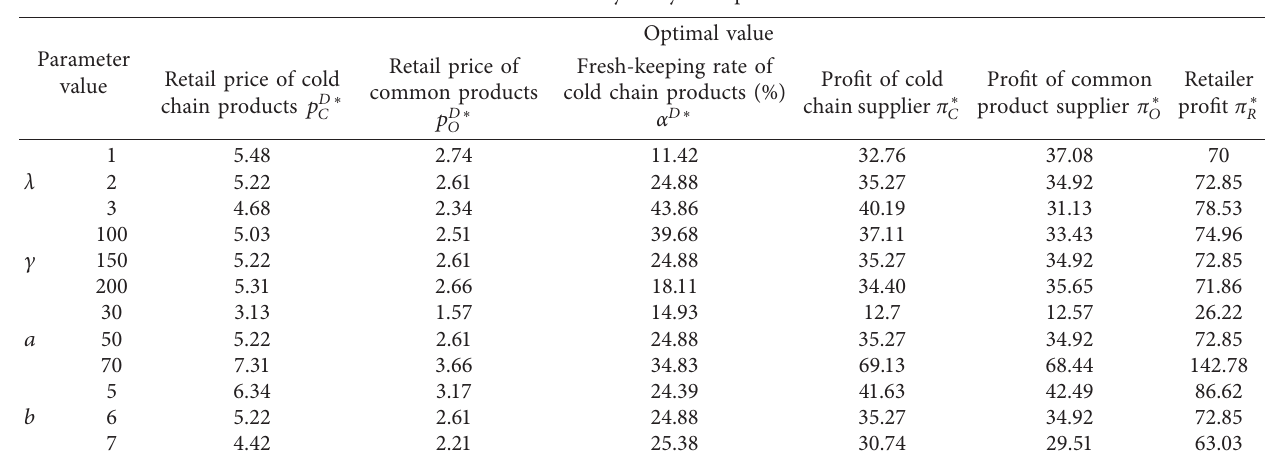
Table 3: Sensitivity analysis of